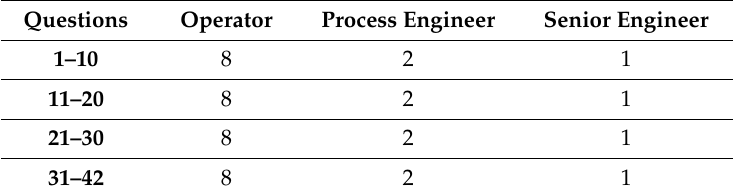
Table A1. Number of professionals